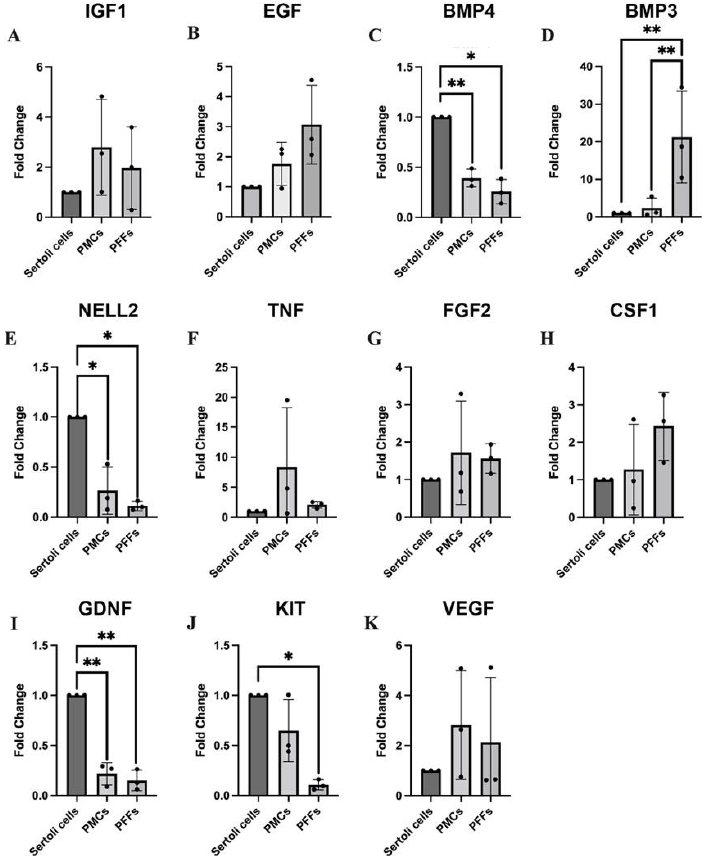
Figure 4. Expression of growth factors in feeders that provide similar levels of support to co-cul- tured spermatogonia. Levels of expression are shown as mean fold change compared to Sertoli cells ( A ) IGF1, ( B ) EGF, ( C ) BMP4, ( D ) BMP3, ( E ) NELL2, ( F ) TNF, ( G ) FGF2, ( H ) CSF1, ( I ) GDNF, ( J ) KIT, and ( K ) VEGF by Sertoli cells, PMCs, and PFFs. Data are presented as mean ± SD (n = 3). A p -value of < 0.05 was considered significant (* p ≤ 0.05, ** p ≤ 0.01).